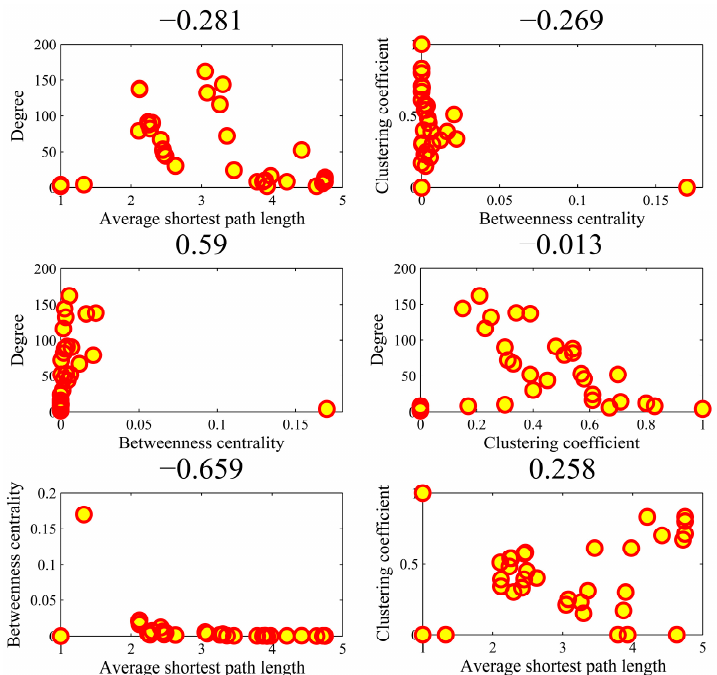
Figure 11. The Spearman rank correlations between the four parameters in the DM (diabetes mellitus) genes.